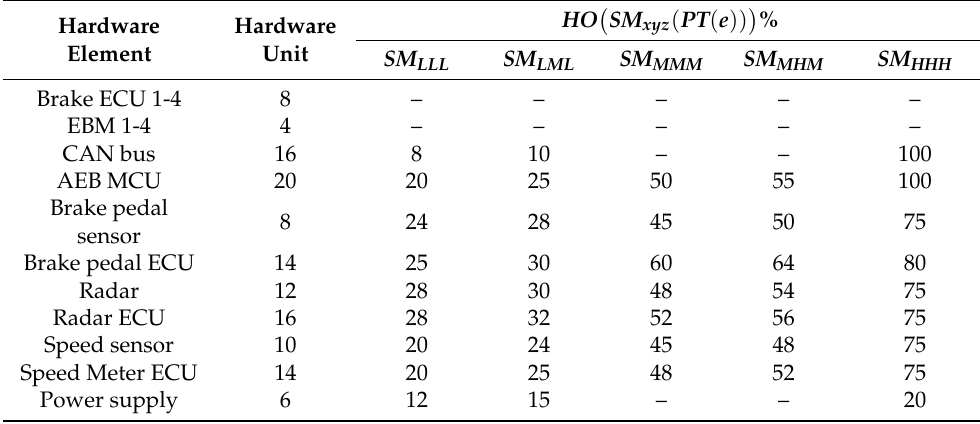
Table 14. Hardware overhead of safety mechanism for each AEB hardware